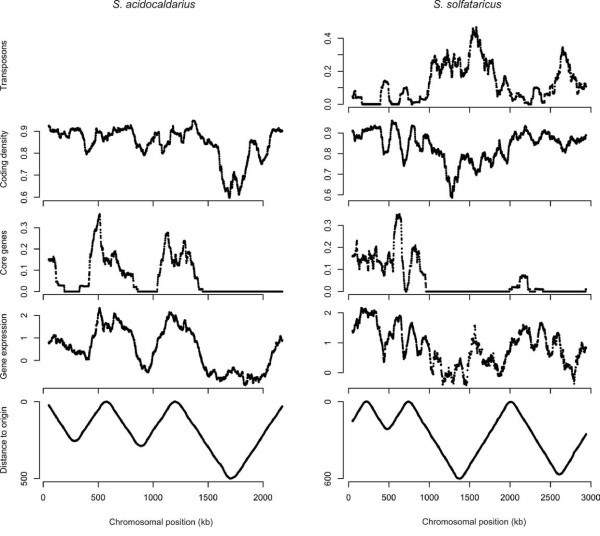
Distance to nearest origin, average gene expression, proportion of archaeal core genes, protein-coding density, and transposable element density over the chromosome of S. acidocaldarius (left panel) and S. solfataricus (right panel) in 100 kb sliding windows, translocated in 1 kb steps. Chromosomal positions for window mid-points are shown on the x-axis.